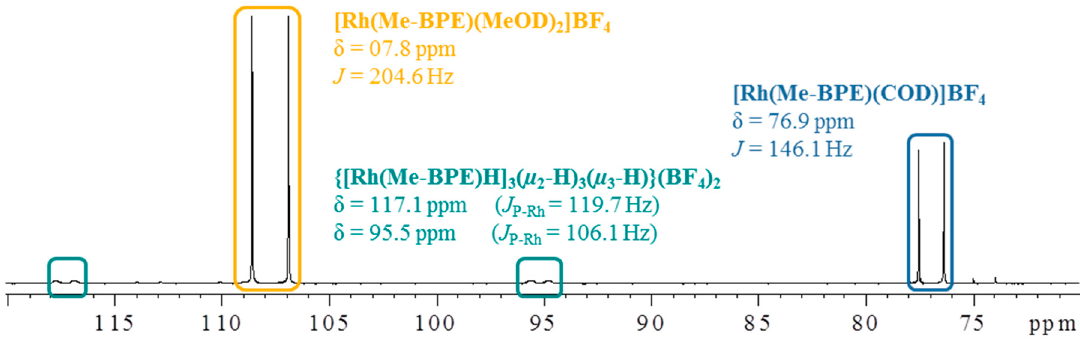
Figure 10. Molecular structure of the hydride complexes {[Rh(DCPE)H] 2 ( µ 2 -H) 3 } + , left, and